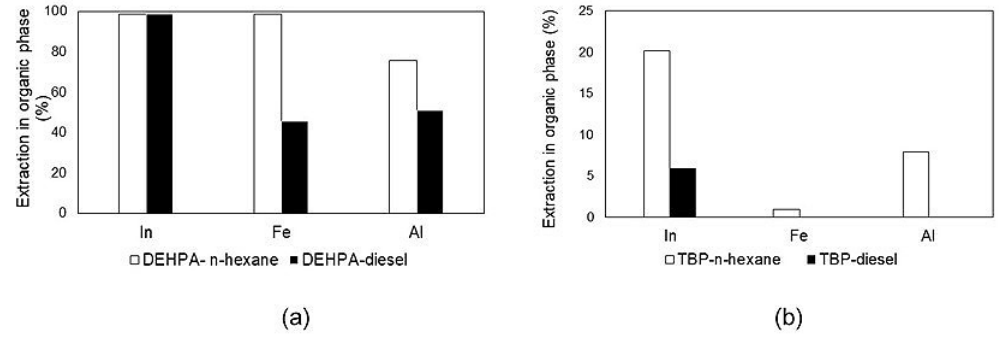
Figure 7. ( a ) Recovery of In, Fe, and Al with DEHPA (1.0 M, pH = 1.7) with n -hexane and diesel as diluents; ( b ) Recovery of In, Fe and Al with tributyl phosphate (TBP) (1.0 M, pH = 1.7) with n -hexane and diesel as